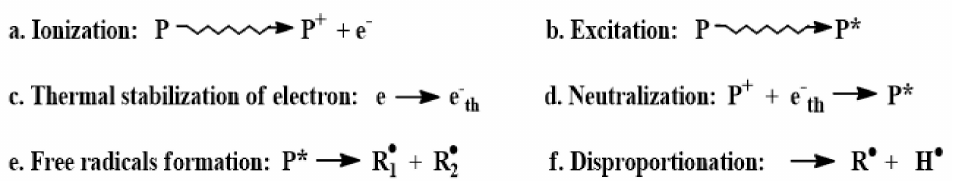
Figure 2. Primary processes occurring of polymer in ionising irradiation. * P is a polymer and R • is a radical. Source: Adapted Vasile and Butnaru [26].